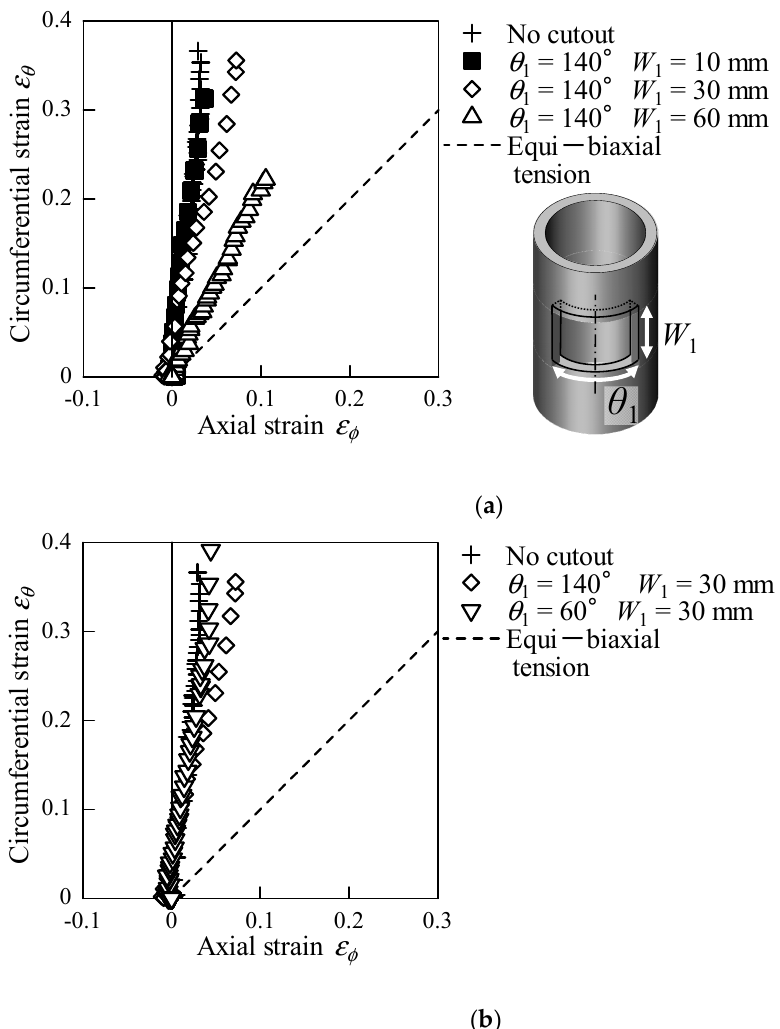
Figure 13. Strain paths of specimen with and without a square cutout; ( a ) different axial length W ₁ and circumferential angle θ ₁ of 140° ( b ) different circumferential angle θ ₁ and axial length W ₁ of 30 mm.